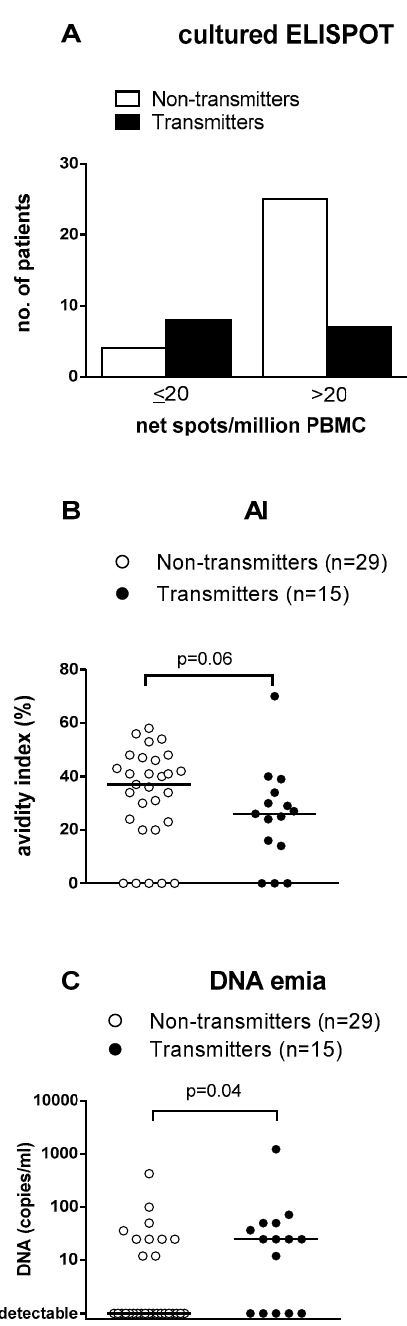
Figure 4. ( A ): Cultured ELISPOT assay. Using a pp65-specific T cell determination, it was found that pregnant women with >20 spots/10 6 PBMC transmitted the infection to the fetus at a significantly lower rate than women with <20 spots/10 6 PBMC. ( B ): among serological parameters, IgG AI was higher in NT compared to T women. ( C ): viral load in blood was significantly lower in NT compared to T women